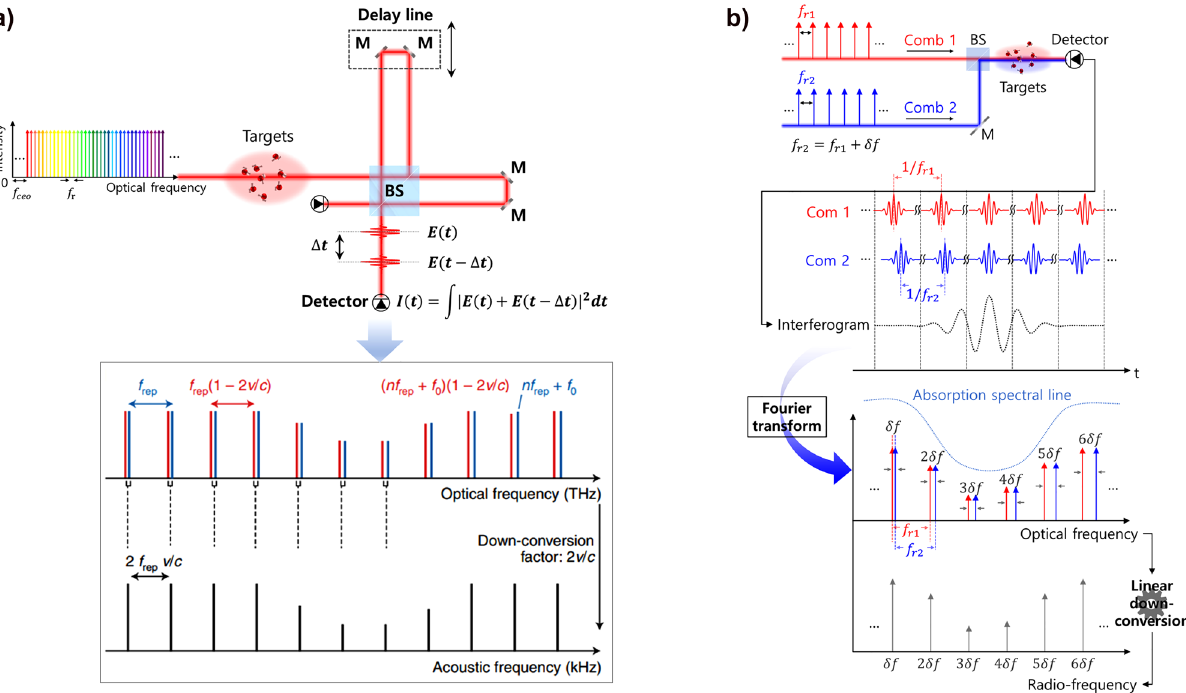
Figure 20: Various frequency comb spectroscopic techniques. (a) Michelson-based Fourier transform spectroscopy using an optical frequency comb. The optical frequency comb has the information of the target by passing through target molecules. The encoded target information can be observed through an interferogram obtained by the two detectorsintheformoftheequation, I ( t ) = ∫ | E ( t ) + E ( t − Δ t )| 2 d t ,whichisgeneratedbythetimedelay Δ t usingadelayline.Theresultantcan be formed in the interval of the Doppler frequency generated by scanning the delay line [112]. (b) Dual-comb spectroscopy. The two optical frequencycombs that have a slightly different repetition rate passthe targets. The differenceof the repetition rate providesthe interferogram using a detector, and it is transformed by the Fourier transform in the frequency domain. The absorption spectral line of the target molecules can be acquired by monitoring the beat frequency between the two combs, which is down-converted to the RF region by a multiheterodyne mixing with a slightly different repetition frequency δ f . M, mirror; BS, beam